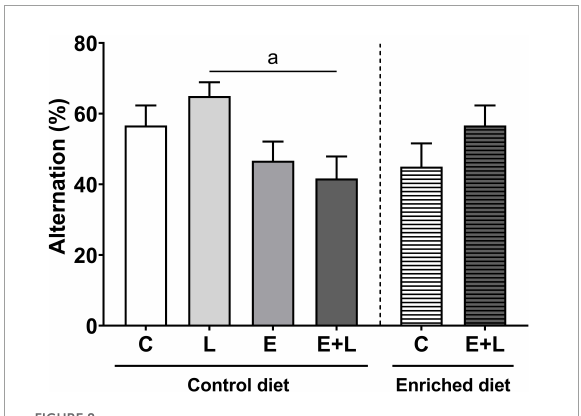
FIGURE8 Cognitive function as measured with the T-maze spontaneous alternation test at T2 of the study (days 56–57). Alternation rates are depicted as percentages. Data are expressed as mean ± SEM ( n = 10 per group). a p < 0.05 (first analysis for elastase and/or LPS effects). C, control; L, LPS; E, elastase; E + L, elastase plus